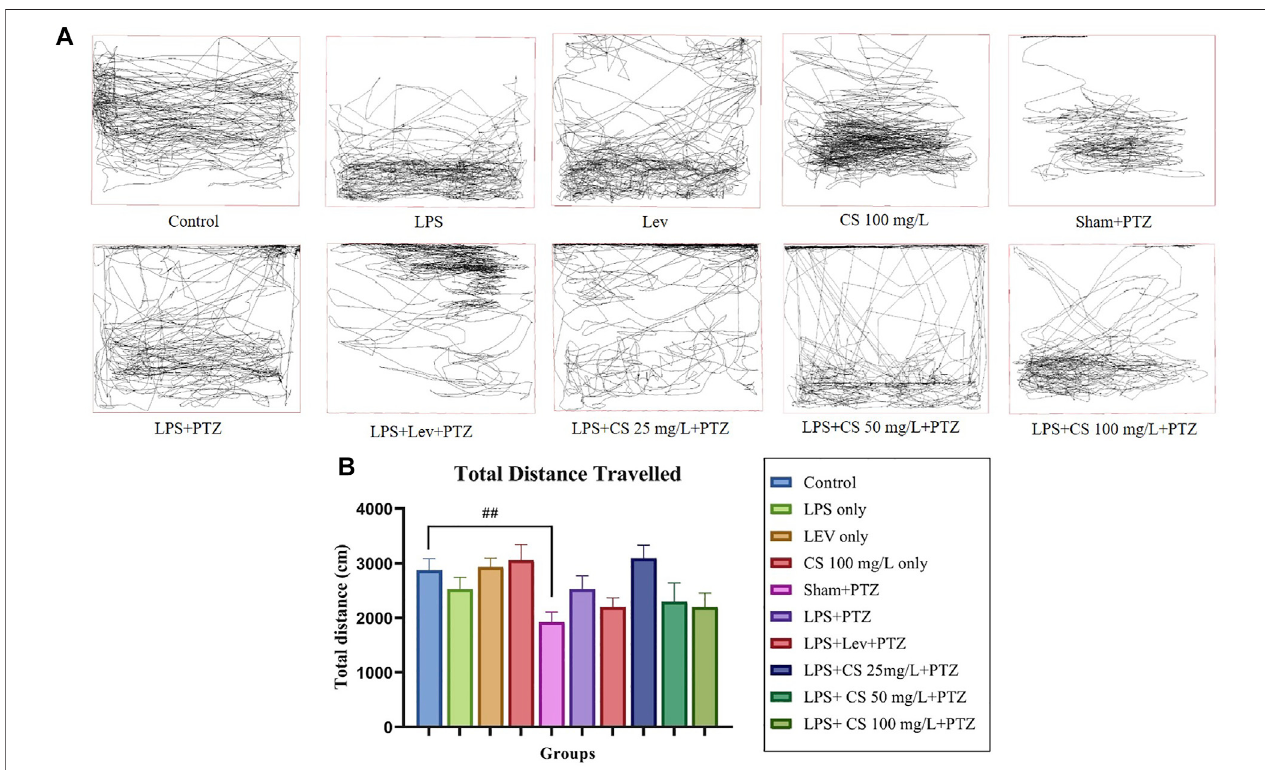
FIGURE1|(A) Representativeswimmingpatternofzebra fi shineachgroup. (B) Meantotaldistancetravelled(cm)byzebra fi shineachgroup.The p -values**** p < 0.0001, *** p < 0.001, ** p < 0.01, and * p < 0.05 were regarded as statistically signi fi cant for the treatment groups compared to the negative control (LPS + PTZ).